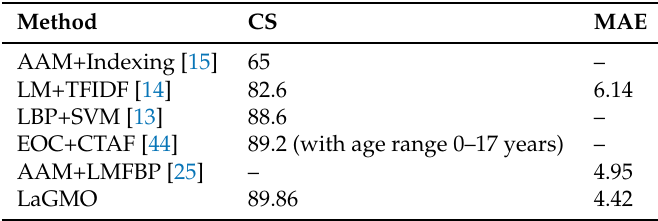
Table 3. Comparison with similar approaches (CS and